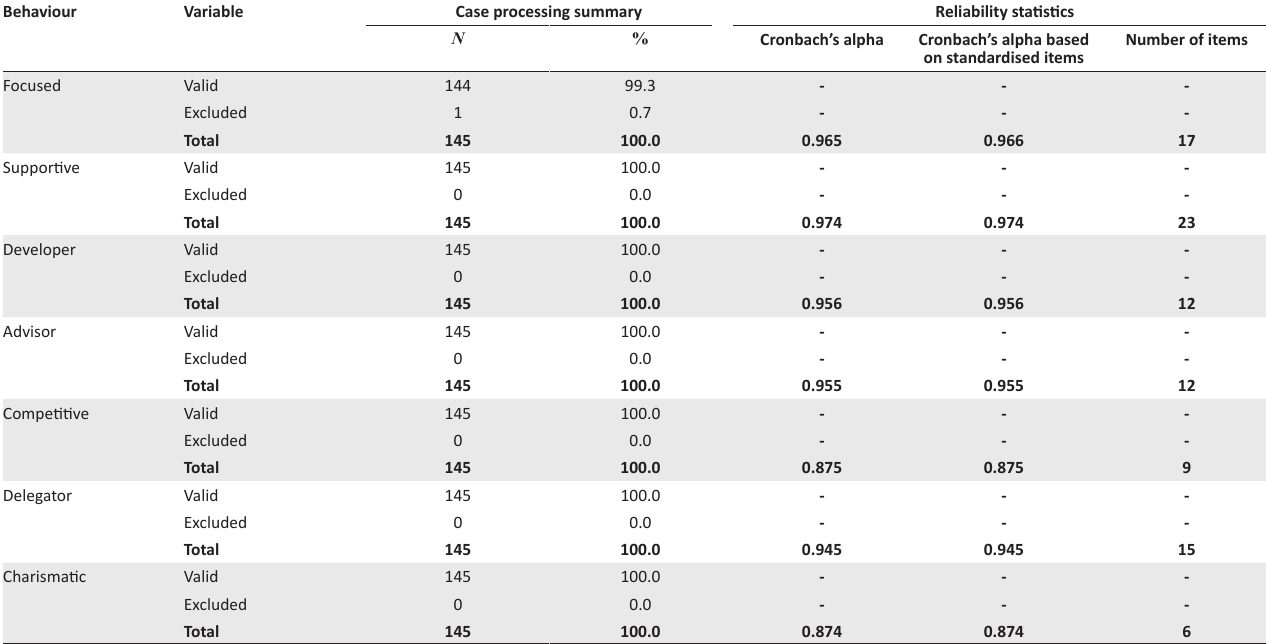
TABLE 7: Reliability statistics for the Leader Behaviour Questionnaire.